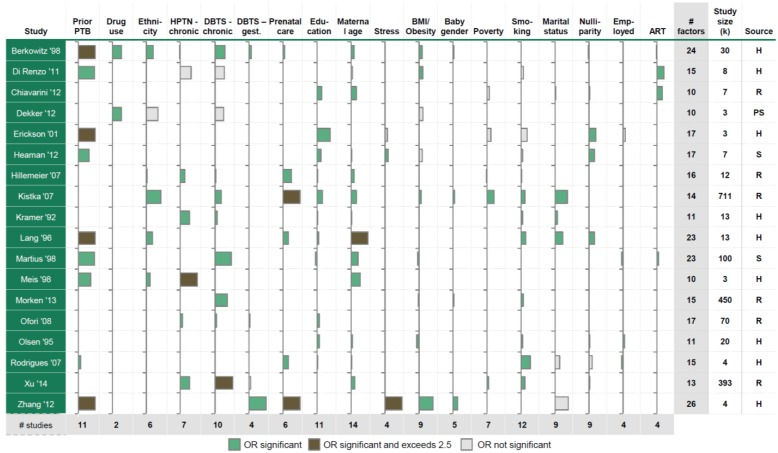
Systematic review of previously published multivariate analyses of preterm birth [19–36].Each bar represents the difference between the reported odds ratios and 1; positive/negative bars are associated with increased or decreased risks of preterm birth respectively. Where categorical variables were reported, we reported the category having the largest significant odds ratio. We included all risk factors considered by at least 3 studies. Reference categories are the following: non-Hispanic white (ethnicity) (all studies, except Dekker '12 (non-Caucasian)); prenatal care beginning before 13 (Berkowitz '09) or 14 (Rodrigues '07) completed weeks of gestation, prenatal care received during first trimester (Lang '96), "adequate" (Hillemeier '07), received (Kristka '07), or not received (Zhang '12); high education (all, except Lang '96, Rodrigues '07), high-school graduate (Lang '96), 4–8 years of school education (Rodrigues '07); age > 20 (Kistka '07), age 20–29 (Berkowitz '09, Chiavarini '12), age 25–29 (Hillemeier '07), age 25–34 (Lang '96, Xu '14), age 18–30 (Meis '98), age 20–34 (Kramer '92), age 20–35 (Heaman '12, Olsen '95), age < 35 (Di Renzo '11); low perceived stress; healthy BMI; female baby; non-smokers; least deprived population; married. For categorical variables only the category with the largest significant odds ratio is shown; ethnicity: Black (Berkowitz '98, Hillemeier '07, Kristka '07, Meis '98, Lang '96), Caucasian (Dekker '12); education: lowest education (all studies); age: < 15 (Lang '96), < 20 (Berkowtiz '98, Kristka '07, Olsen '95), > 30 (Meis '98), > 35 (Di Renzo '11, Heaman '12, Hillemeier '07, Kramer '92, Rodrigues '07), > 40 (Chiavarini '12); BMI/Obesity: < 20 (Berkowtiz '98, Dekker '12, Kristka '07, Olsen '95), > 25 (Di Renzo '11), > 30 (Zhang '12), > 45 (Xu '14); poverty: high level (Erickson '01, Hillemeier '07, Kristka '07, Xu '14). A missing bar indicates that the risk factor was not considered in the study. Abbreviations: PTB, preterm birth; HPTN, hypertension; DBTS, diabetes; BMI, body mass index; gest., gestational; ART, assisted reproductive technology; OR, odds ratio; H, hospital; R, registry; S, survey; PS, prospective study.